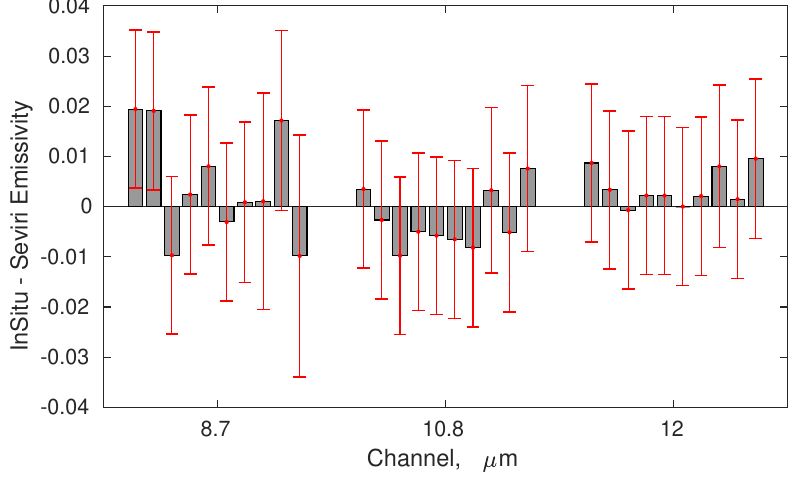
Figure 7. Differences in situ KF retrieval emissivity for the three SEVIRI TIR channels. The comparison includes all in situavailable observations shown in Table 4.